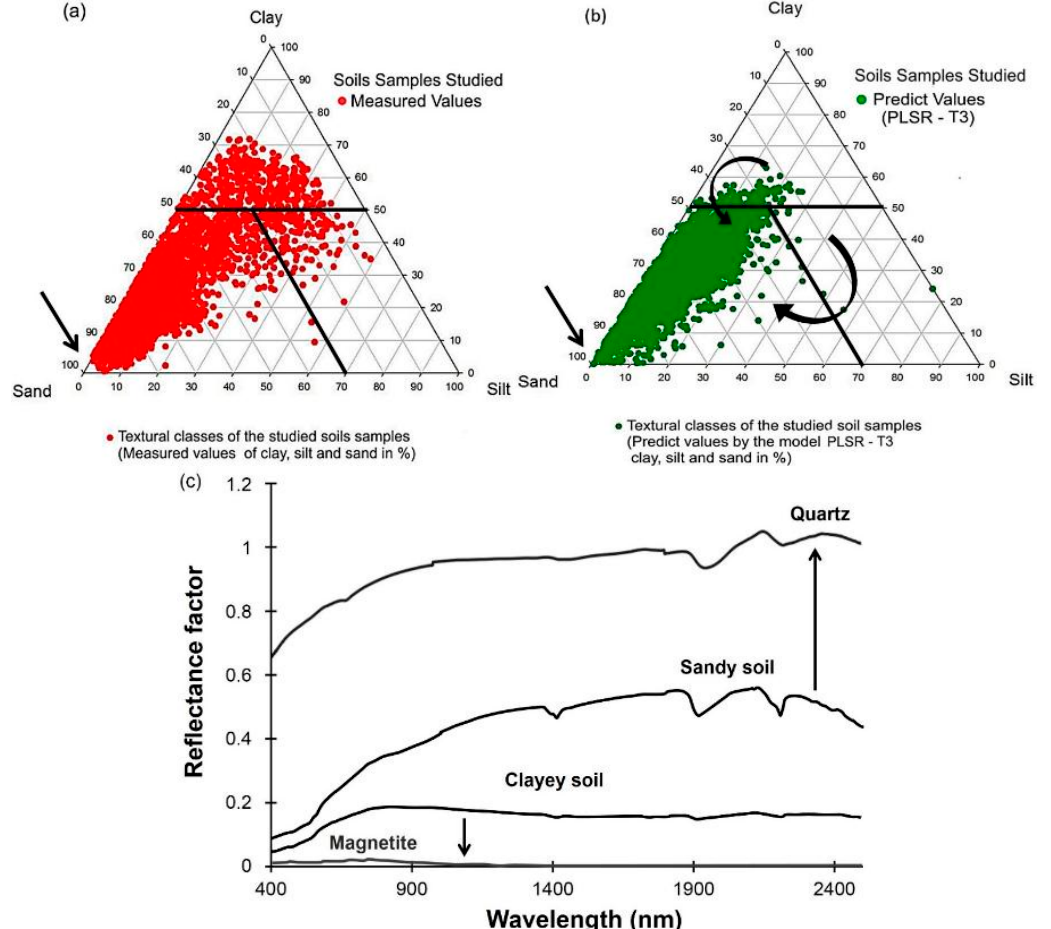
Figure 8. Ternary diagram of soils textural classification: ( a ) clay, silt and sand measured; ( b ) clay, silt and sand predicted by the model with Treatment 3; and ( c ) representative spectral curves (Adapted from Cezar et al. [58]).